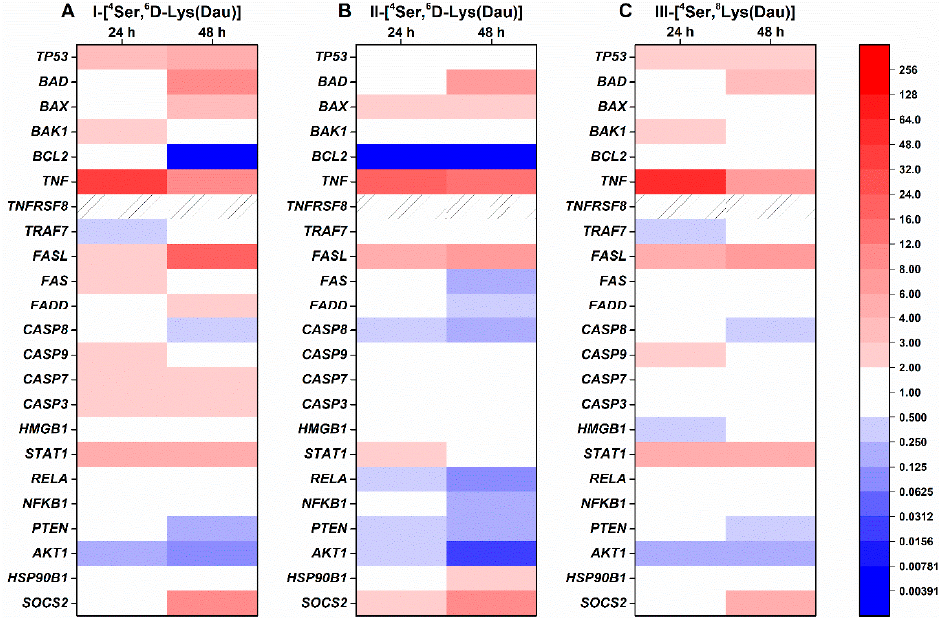
Figure 3. Expression of human apoptosis-related genes in HT-29 cells treated with GnRH-[ 4 Ser] conjugates for 24 and 48 h. Effects of I-[ 4 Ser, 6 D-Lys(Dau)] ( A ), II-[ 4 Ser, 6 D-Lys(Dau)] ( B ), III-[ 4 Ser, 8 Lys(Dau)] ( C ) on gene expression were analyzed by a human apoptosis gene PCR array (RealTime ready custom panel). The colors of the heatmap show significant fold changes in gene expression compared to control. Fold changes ≥ 2 and p < 0.05 were considered as significant. A